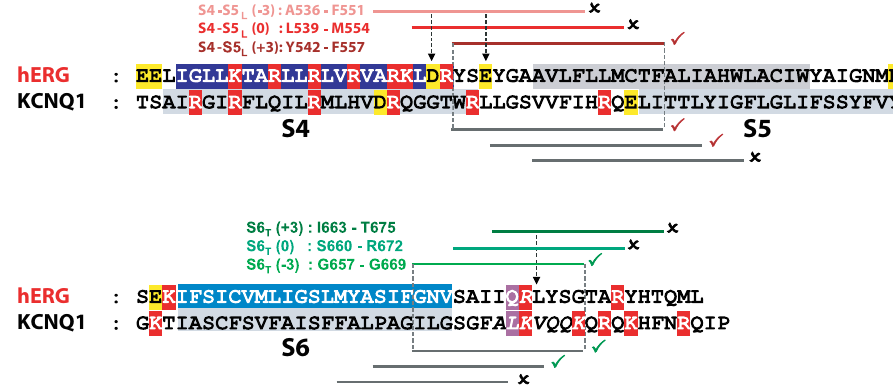
Figure 9. hERG inhibiting (S4-S5 L ( + 3)) and activating peptides (S6 T ( − 3)) are aligned with KCNQ1 inhibiting and activating peptides. Same as in Fig. 1B, onto which the results obtained with hERG have been added. A check sign (✓) indicates that the S4-S5 L peptide inhibits the channel and that the S6 T peptide activates the